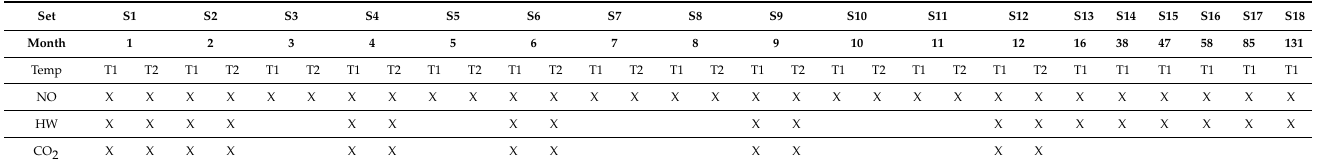
Table 1. Treatment conditions for Experiment 1.